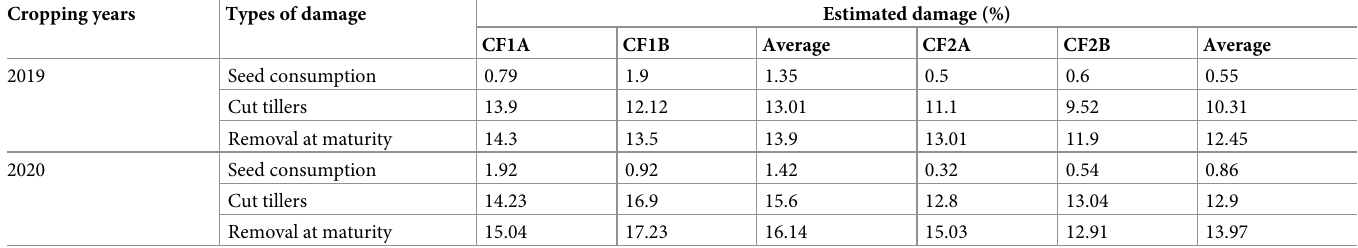
Table 3. Pest damage on different stages of barley crop at the two cropping sites in 2019 and 2020 cropping years (CF1A, B = Crop field near the forest, CF2A, B = crop field away from the forest). Cropping